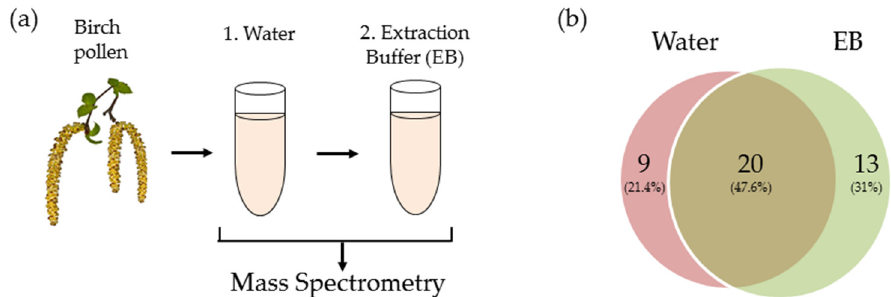
Figure 2. Sample preparation for mass spectrometry, consisted of two consecutive steps: ( a ) 1. Water extraction; 2. Trypsin extraction buffer (EB). The results of mass spectrometry analysis (cross-verified with transcriptomic data), identified a total of 42 proteases for both solutions, distributed as shown in ( b ). Birch pollen image adapted from image purchased from foltolia.com.